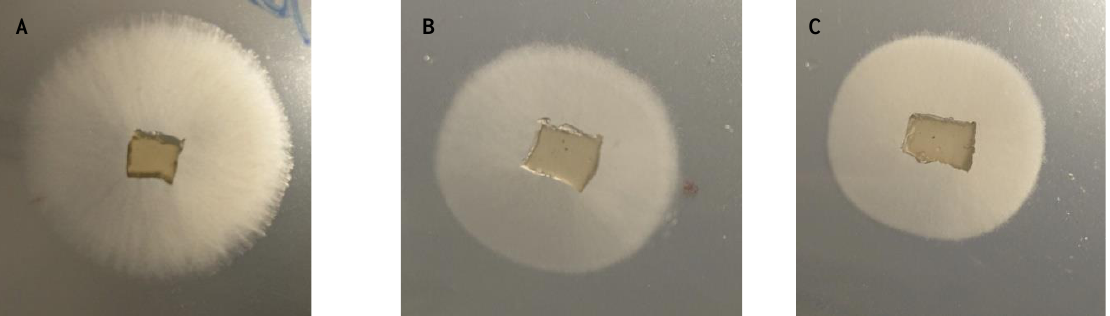
Fig. 5 The colony morphology of an individual disc colony of Serendipita indica growing on petri dishes containing seven concentration rates of Fulvic acids ( A ) and Humic acid ( B ) in comparison with the controls ( C )